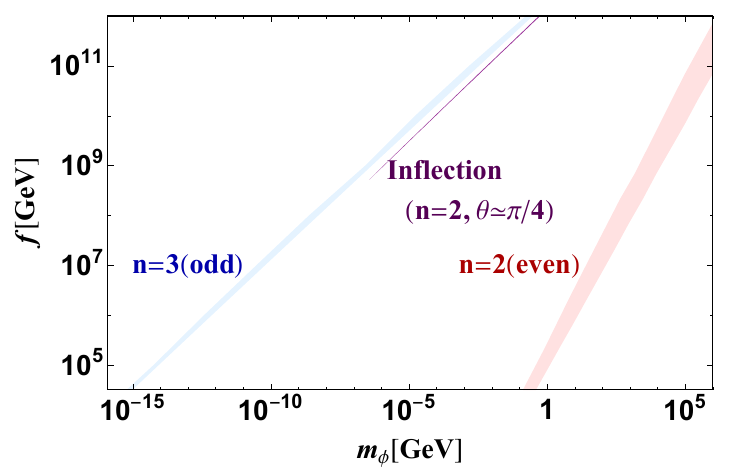
Figure 2 . The relation between inflaton mass and the decay constant. The red band shows the even case with n = 2. The blue band of n = 3 and the purple line of inflection point inflation are also shown for